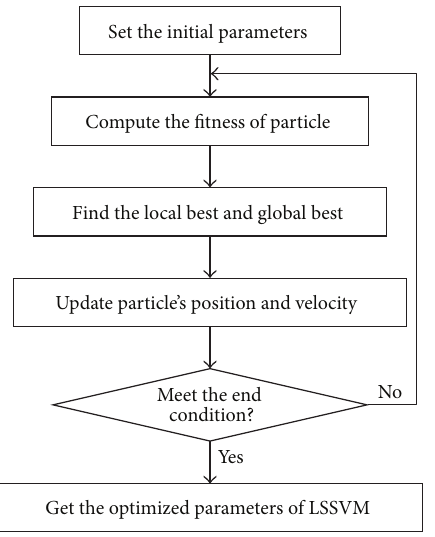
Figure 2: Process of optimizing the LSSVM parameters with PSO. parameters (only the regularization parameter 𝜆 and kernel parameter 𝜎 ), we select it to construct the LSSVM.